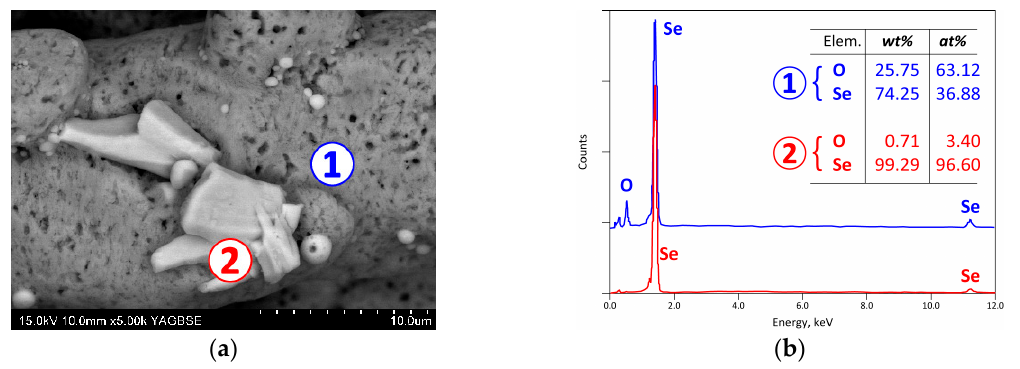
Figure 10. SEM-EDS results of a condensate obtained during thermal treatment of the Cu-anode slime sample: ( a ) General view (backscattered electron micrograph) of SEM with two different phases; ( b ) EDS analysis of the same phases.